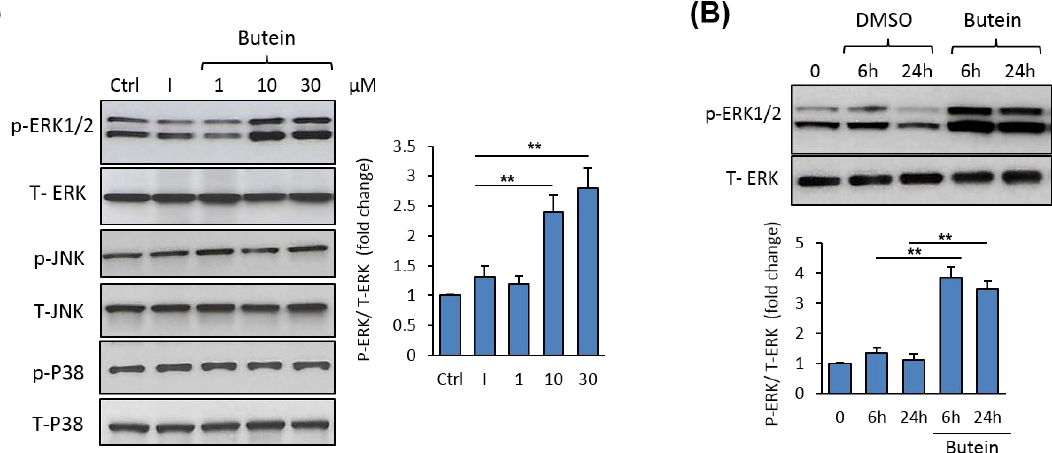
Figure 3. Inhibitory e ff ect of butein on adipogenesis of mBMSCs. ( A ) Dose-dependent inhibitory e ff ect of butein on adipocyte di ff erentiation of mBMSCs. Cells were either non-induced (Ctrl, control), or induced with an adipogenic cocktail in the presence of DMSO (I + DMSO) or di ff erent concentrations of butein for 12 days. Lipid accumulation was measured by quantification of Oil Red O staining. ( B ) Images for Oil Red O staining. ( C ) qPCR analysis of mRNA expression of some adipocyte-related genes at day 12 of adipogenesis of mBMSCs in the presence of di ff erent concentrations of butein. Each target gene was normalized to the reference genes and represented as a fold change over di ff erentiated cells without butein. Values are mean ± SD of three independent experiments, (* p < 0.05, ** p < 0.005).